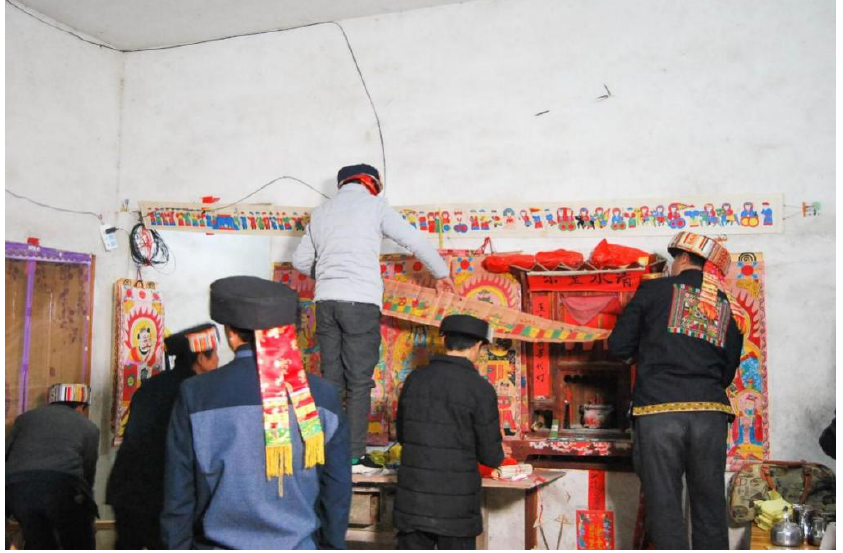
Figure 4. Hanging up the paintings of the gods.